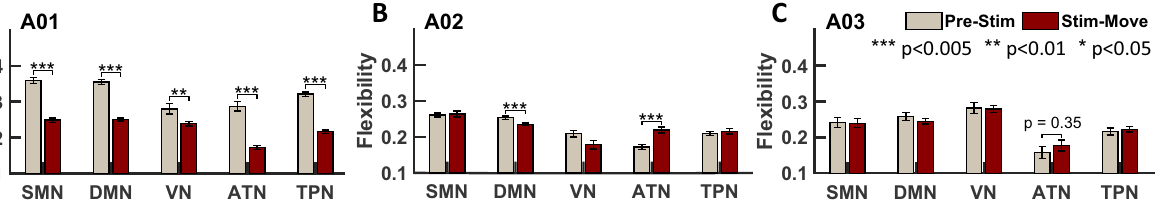
Figure 4. System level changes in flexibility during sensory stimulation (Stim-Move), compared to Pre-Stim for participants A01 (A), A02 (B), and A03 (C). ( A ) All large-scale systems showed decrease in flexibility for A01. ( B ) DMN showed decreased and ATN showed increased flexibility for A02. All error bars represent the standard error of the mean. A01: n = 30 each bar; A02: n = 20 each bar; A03: n = 10 each bar. ∗ p < 0.05 . See Supplementary Table S2 for statistical power analysis.